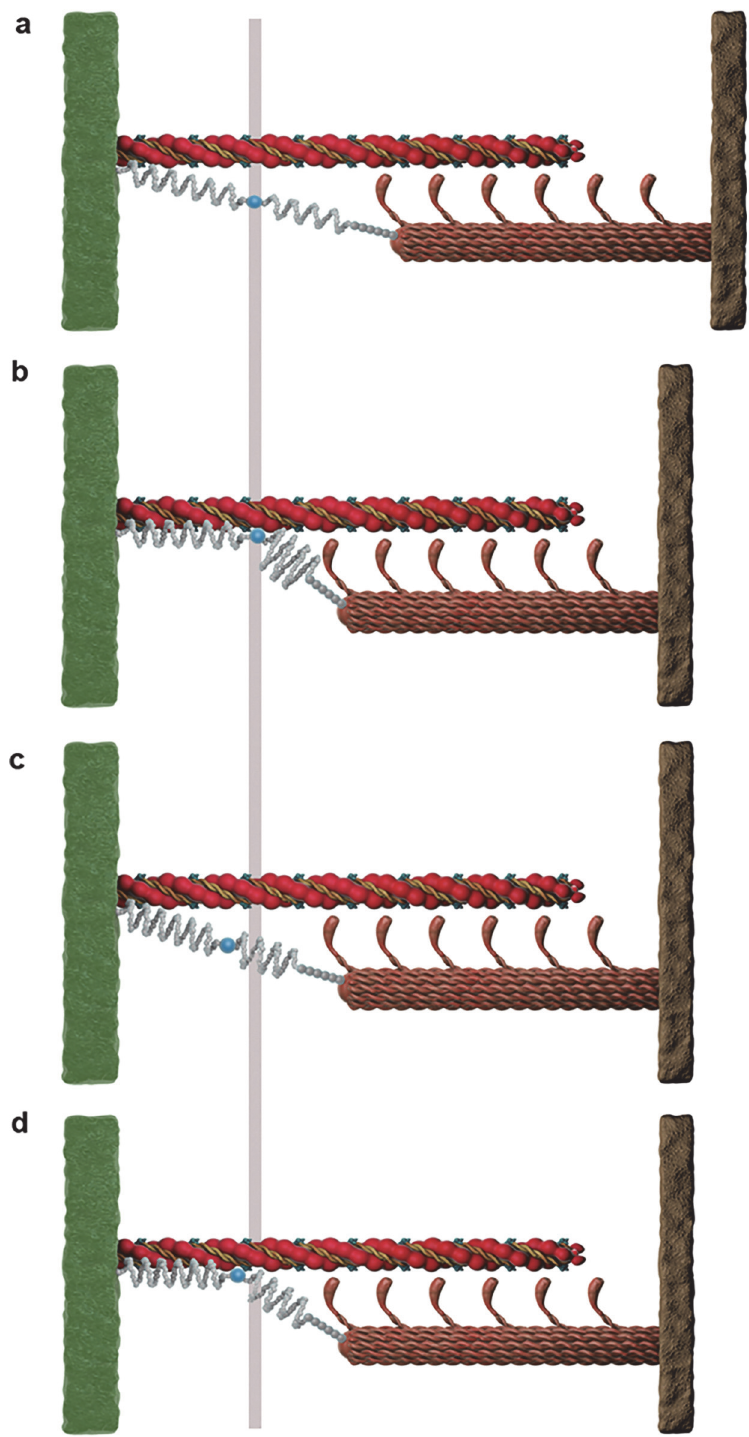
Fig 7. Illustration of active shortening of a sarcomere based on the three filament model. a , The sarcomere is passively stretched to a length of 2.6 μ m, activated and b , shortened to 2.4 μ m. The resulting force is compared to the isometric force at 2.4 μ m, where the sarcomere is activated at a length of 2.4 μ m and the elongation of its free spring length is higher, whether titin is attached to actin d or not c .